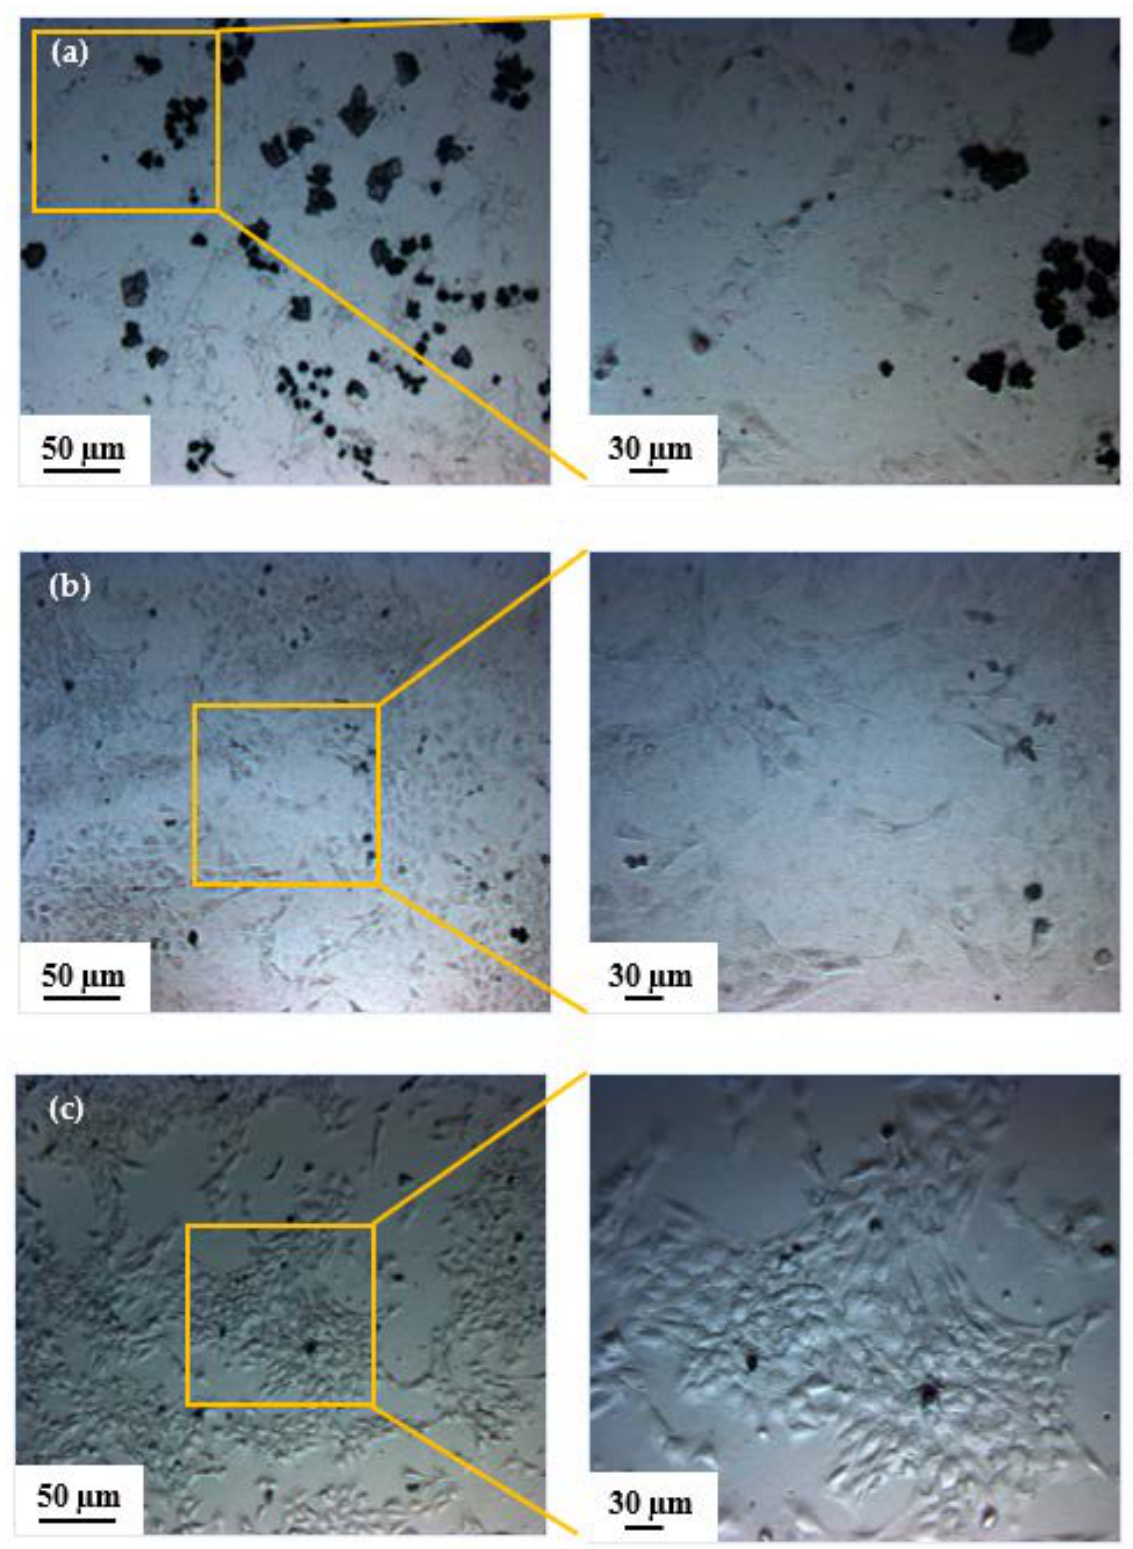
Figure 3. Optical images of replicated cells onto conductive polymers with different concentrations of glycerol: ( a ) 2%, ( b ) 3% and ( c ) 4%. By increasing the percentage of glycerol in PEDOT:PSS the replication resolution was improved. The black spots in ( a ) are some debris from the PEDOT:PSS formation on the bioimprinted cellular features.